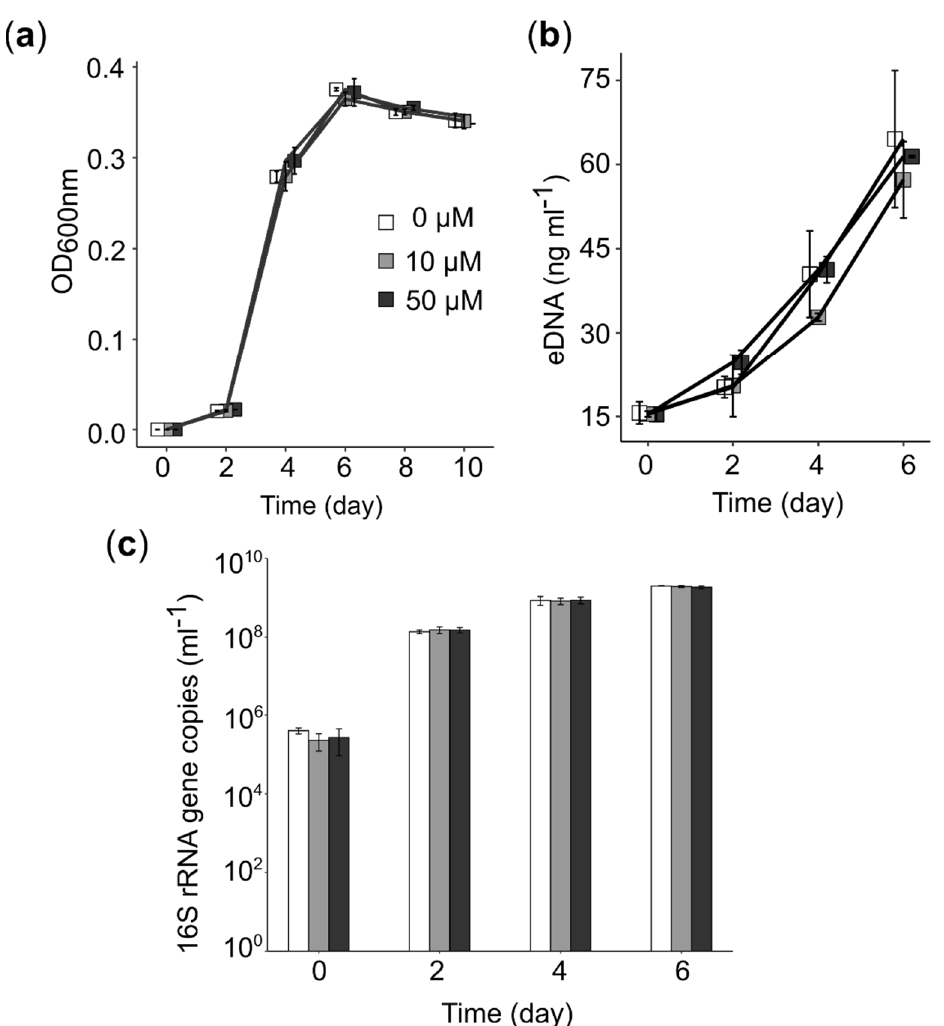
Figure 6. Effect of PEA on eDNA release and growth in Acidiphilium sp. C61. (a) Growth curve of Figure 6. E ff ect of PEA on eDNA release and growth in Acidiphilium sp. C61. ( a ) Growth curve of Acidiphilium sp. C61 culture supplemented with different concentrations of PEA (0 µM, white; 10 µM, Acidiphilium sp. C61 culture supplemented with di ff erent concentrations of PEA (0 µ M, white; 10 µ grey; 50 µM, black), n = 3. (b) eDNA concentration in cultures of Acidiphilium sp. C61 supplemented